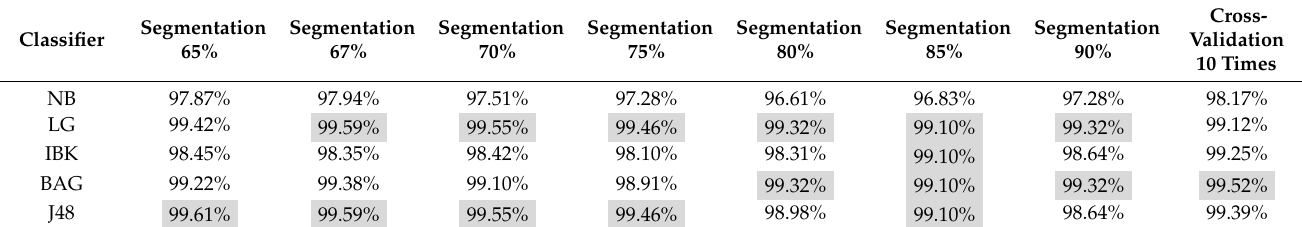
Table 8. The classifier accuracy of feature selection for 982 normal and 491 bankrupt companies (2:1).